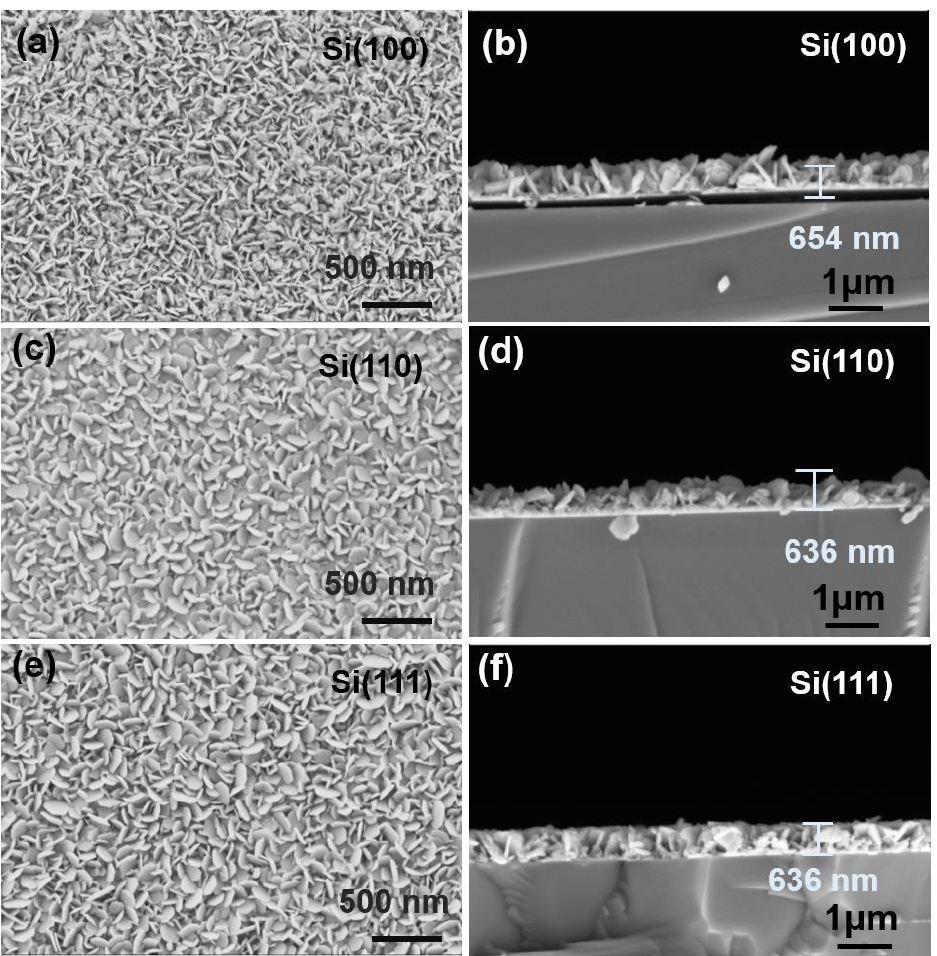
Figure 3. FESEM images of the surface and cross-section microstructures of ( a , b ) Si(100), ( c , d ) Si(110) and ( e , f ) Si(111) Films.